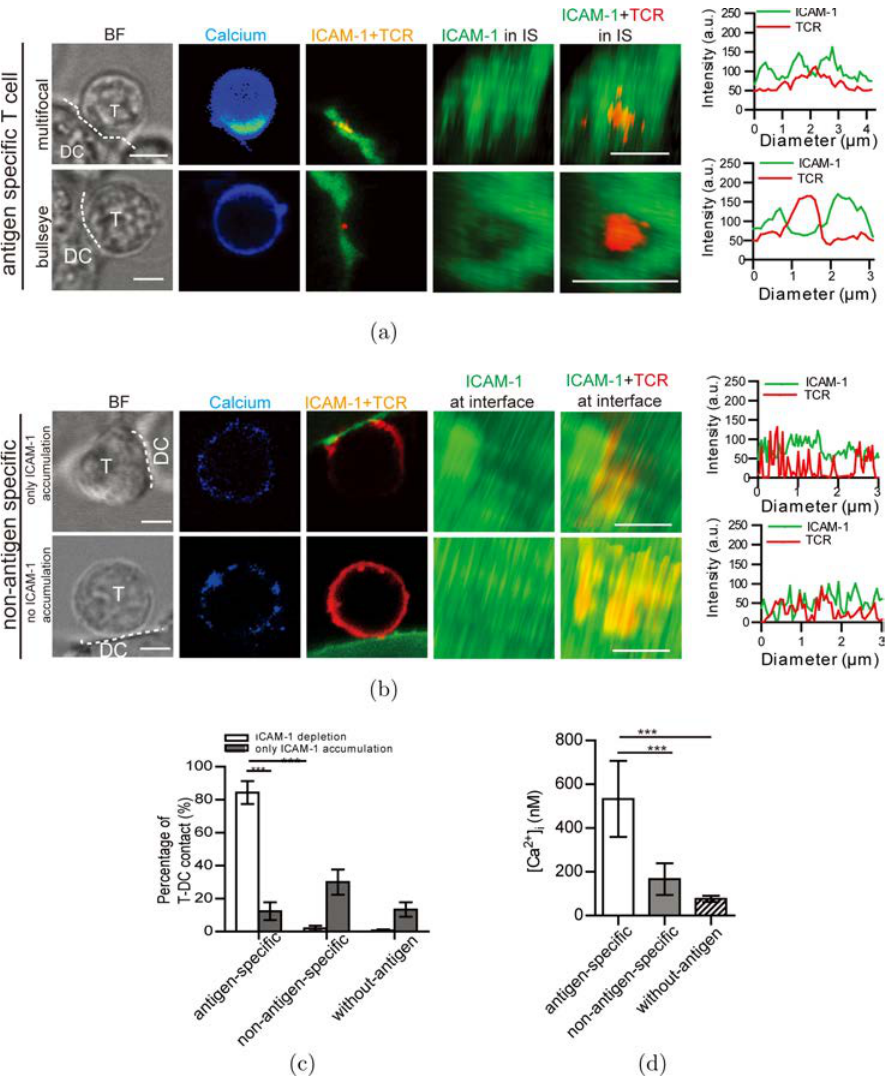
Fig. 3. The localization of ICAM-1 in the IS formed between an antigen-speci¯c/nonspeci¯c T-cell and a DC: (a) The types of synapses formed between an antigen-speci¯c T-cell and a DC. A multifocal IS that had multiple sites for ICAM-1 depletion (the left and upper line) and a bullseye IS that had ICAM-1 depletion in the center of the IS (the left and down line) were formed. The °uorescent distribution of ICAM-1 and TCR along the diameter of the two types of synapses was shown on the right panel. Bar ¼ 2 (cid:2) m. (b) The synapses formed between a nonspeci¯c antigen T-cell and a DC. ISs with only ICAM-1 accumulated at the contact of T-DC or without ICAM-1 accumulation at the contact of T – DC were shown. Bar ¼ 2 (cid:2) m. (c) Percentage of T-DC contact which had ICAM-1 depletion or only ICAM-1 accumulation at antigen-speci¯c-T-cell – DC contact, nonspeci¯c- T-cell-DC contact, or T-DC contact without antigen. (d) The calcium response in antigen-speci¯c T-cells with ICAM-1 depletion at T-DC contact, nonspeci¯c T-cells with only ICAM-1 accumulation at T-DC contact and T-cells without antigens at contact DC. (mean (cid:4) s.e.m., n ¼ 25, three independent experiments), *** p < 0 : 001 (two-tailed Student's t